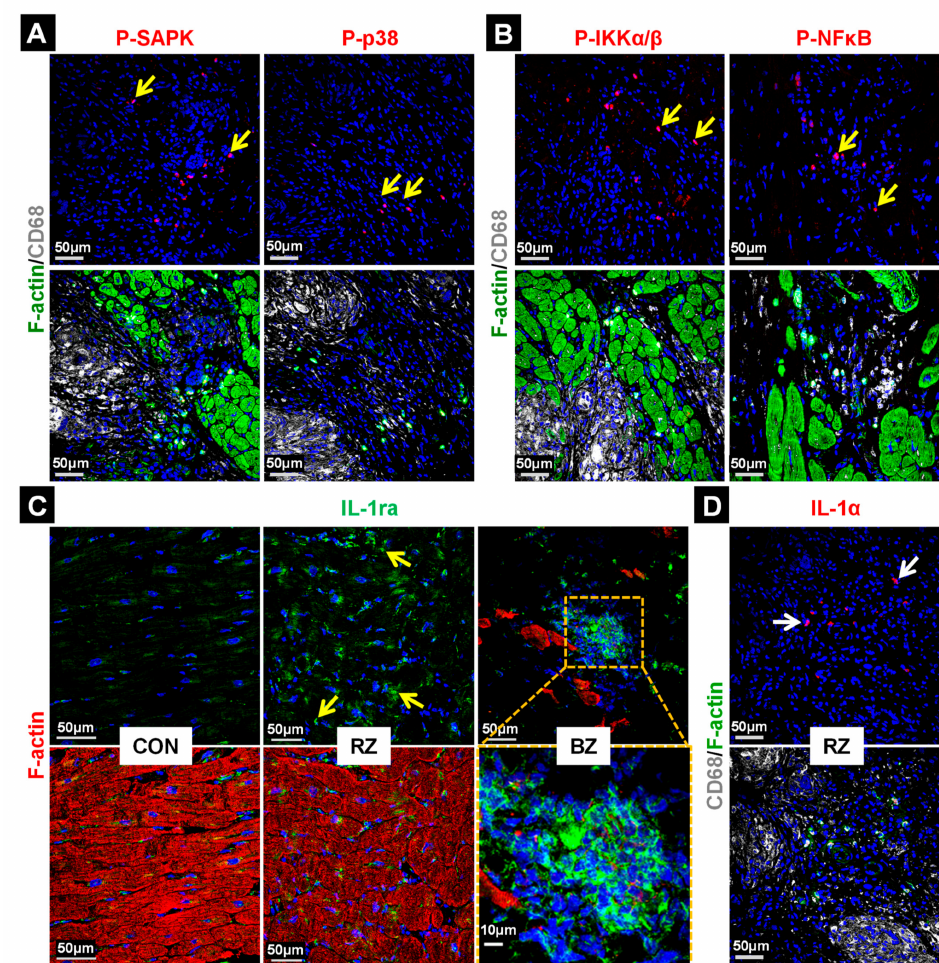
Figure 5. Stress and inflammatory cascades are mildly activated in granulomata. ( A ) Only a few infil- trating cells (yellow arrows) show the activation of the stress mediators SAPK (P-SAPK, Thr183/Tyr185) and p38 (P-p38, Thr180/Tyr182). ( B ) The inflammatory NF κ B/IKK α / β pathway is also lowly activated (P-IKK α / β , Ser176/180; P-NF κ B, Ser536). ( C ) In contrast, the anti-inflammatory interleukin-1 receptor antagonist (IL-1ra) is strongly expressed in macrophages of the granulomata (yellow arrow and enlarged image) and interstitial cells of the RZ and BZ (small yellow arrows). Comparable results were obtained with two different anti-IL-1ra antibodies (Table 2). ( D ) Interleukin-1 α (IL-1 α ) is hardly present in the myocardium of patients with cardiac sarcoidosis (white arrows). The nuclei are stained blue with